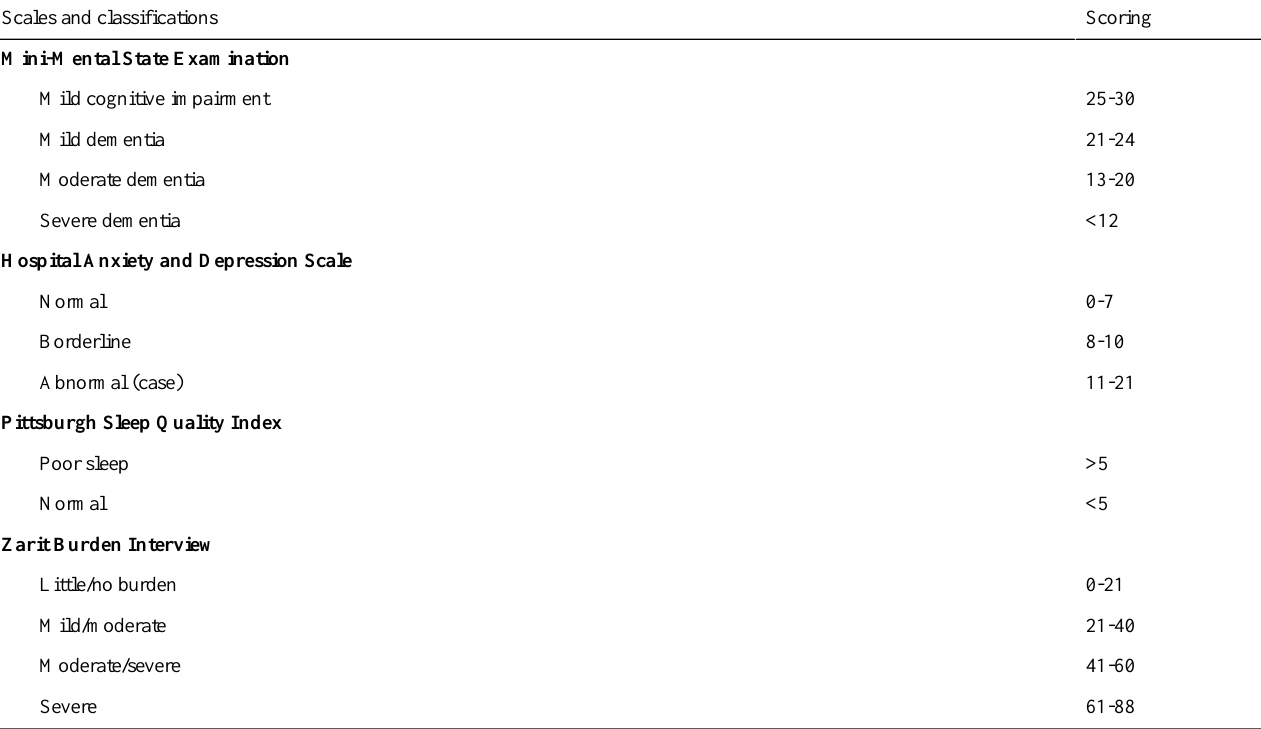
Table 3. Mini-Mental State Examination score and range classification. ScoringScales and